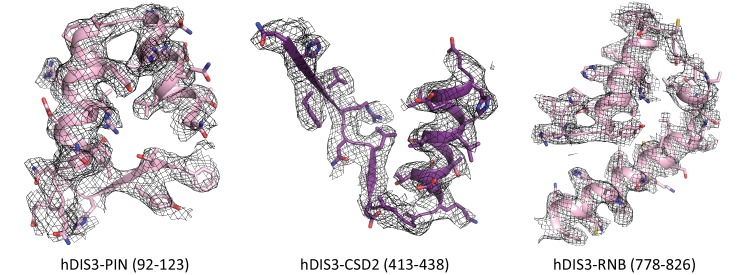
Zoomed in views of the hDIS3.Representative parts of the hDIS3 PIN, CSD2, and RNB domains from the hEXO-10 EM density map, showing secondary structure elements and resolved side chains. Domains and highlighted sequences are marked below corresponding views.